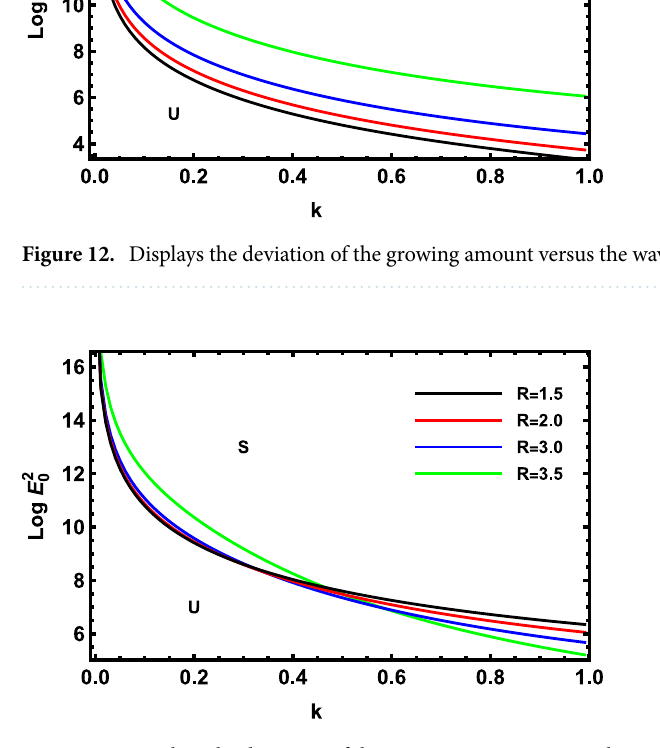
Figure 13. Displays the deviation of the growing amount versus the wave number of cylindrical undisturbed radius R